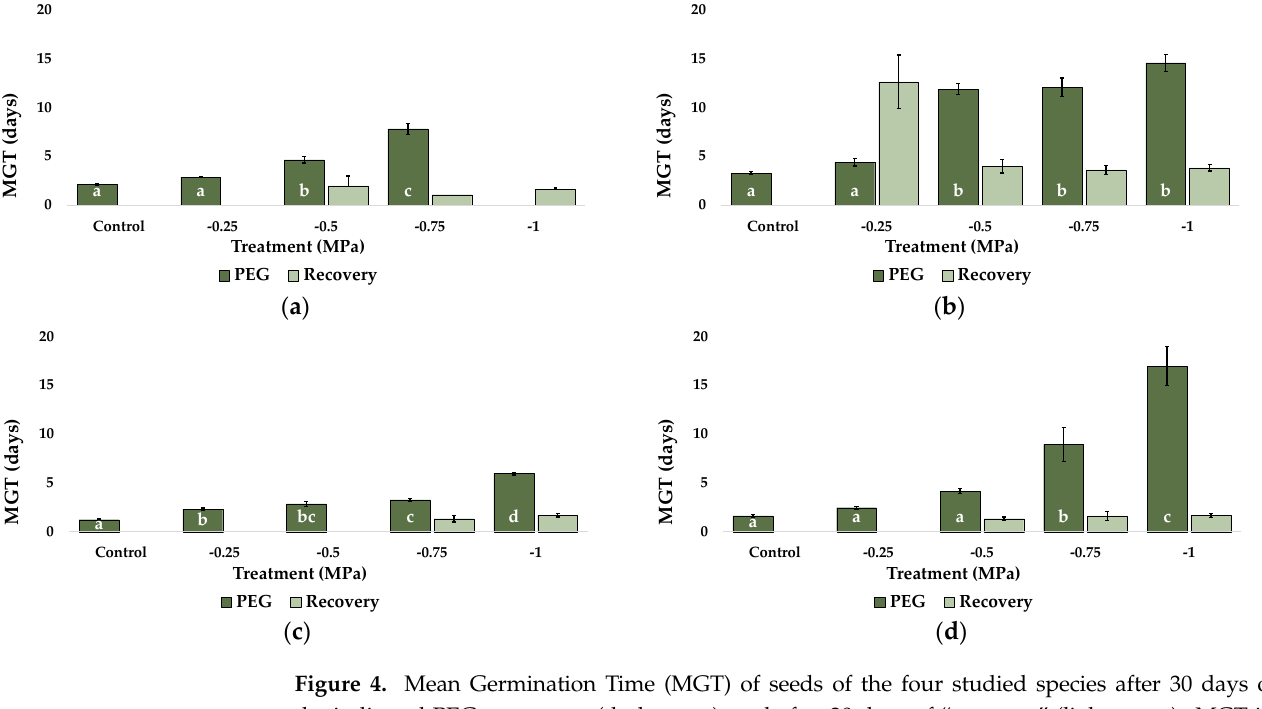
Figure 4. Mean Germination Time (MGT) of seeds of the four studied species after 30 days of the indicated PEG treatments (dark green), and after 20 days of “recovery” (light green). MGT in: ( a ) C. citratus , ( b ) C. selloana , ( c ) P. alopecuroides , and ( d ) P. setaceum . Control: germination in distilled water Values shown are means ± SE ( n = 4). Different lowercase letters within the bars indicate significant differences between treatments, for each species, according to the Tukey post hoc test ( p < 0.05).